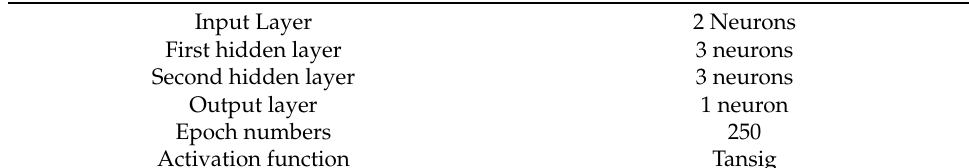
Table 2. The neural network parameters utilized for void fraction measurement .